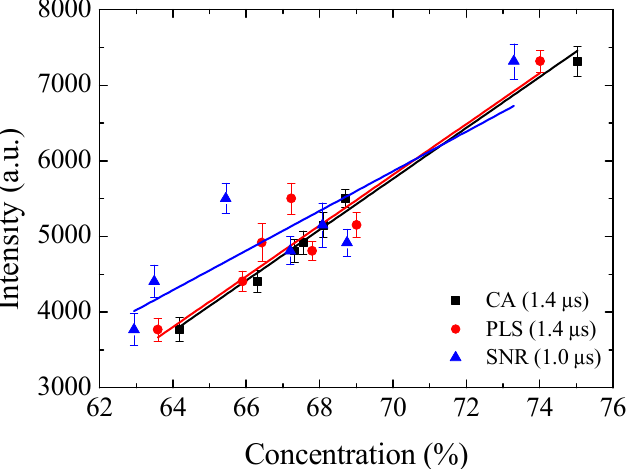
Figure 6. Correlation between the intensity and C concentration with maximum R 2 for CA, PLS, and SNR methods.